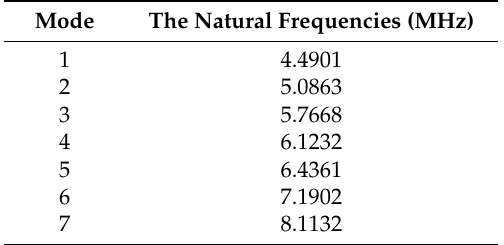
Figure 5. The modes of the bionic structure of tympanic membrane. ( a – g ) The first seven mode shapes. ( h ) The peaks and troughs of the 4th mode. ( i ) The mutual angle between the two degenerate resonance modes. Table 3. The first seven natural frequencies of the bionic